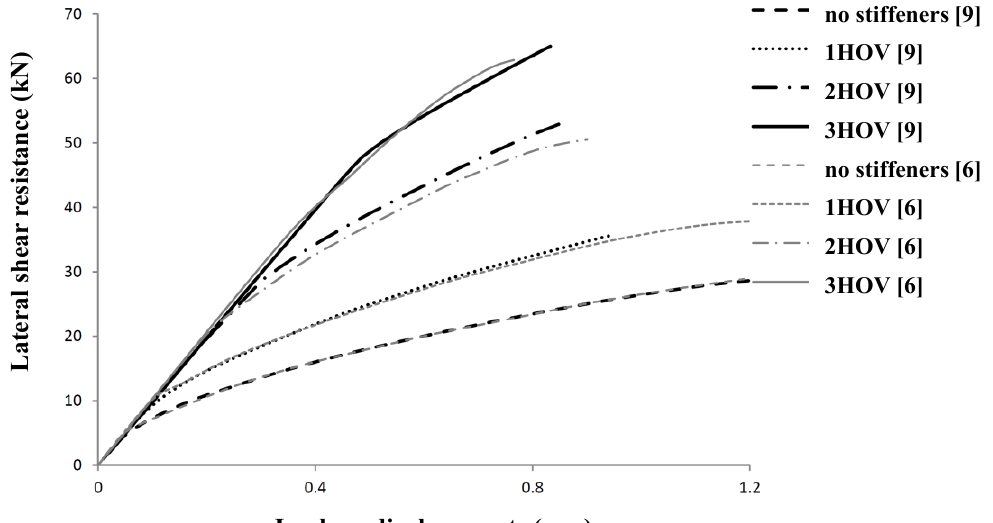
Figure 18. Comparison of lateral shear resistance for several